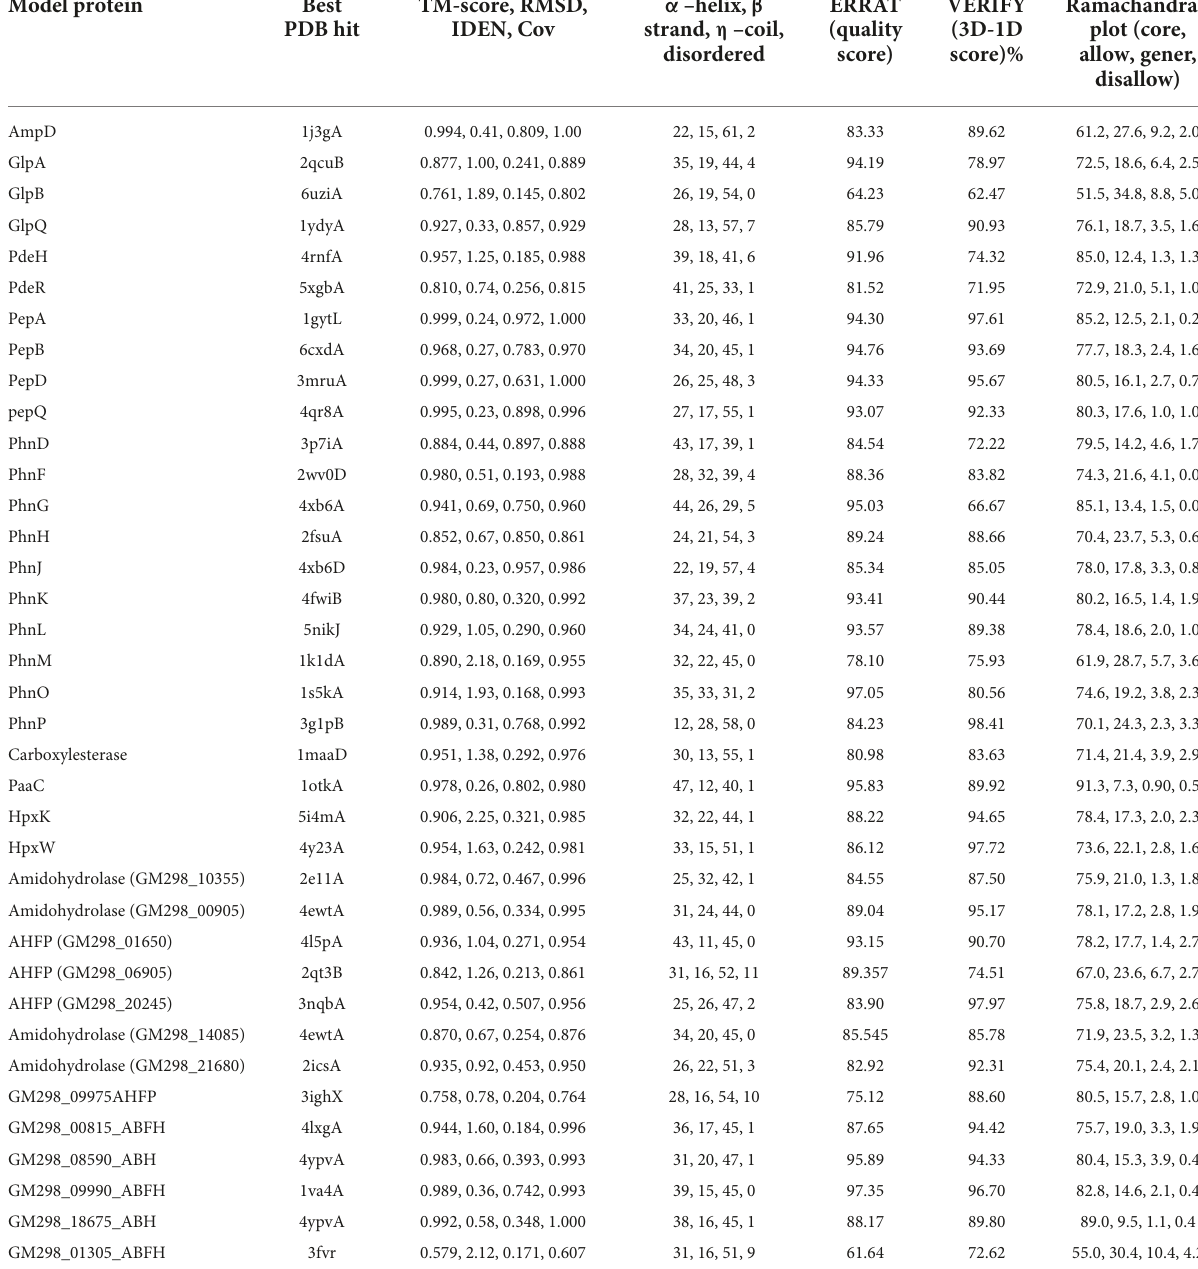
TABLE 6 Pesticide degrading model proteins quality assessment of Enterobacter sp. HSTU-ASh6 strain. Model protein Best